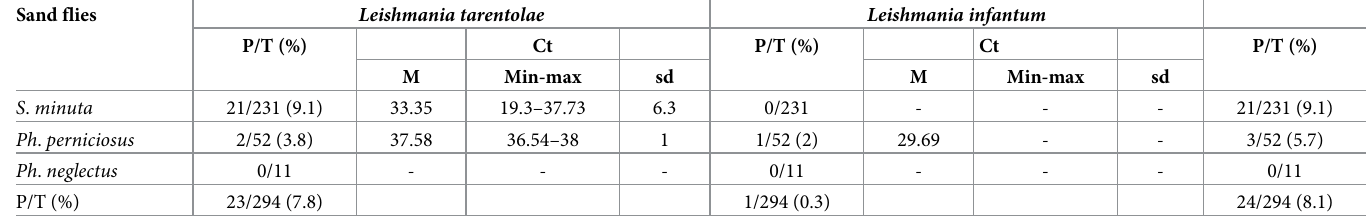
Table 2. Sand fly females tested for Leishmania infantum and/or Leishmania tarentolae by duplex quantitative PCR. The mean (M), minimum (Min), maximum (Max) and standard deviation (sd) values of the threshold cycle (Ct) are reported. Sand